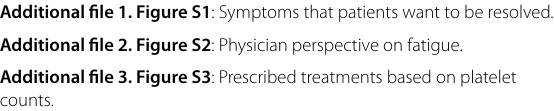
Additional file 2. Figure S2 : Physician perspective on fatigue. Additional file 3. Figure S3 : Prescribed treatments based on platelet